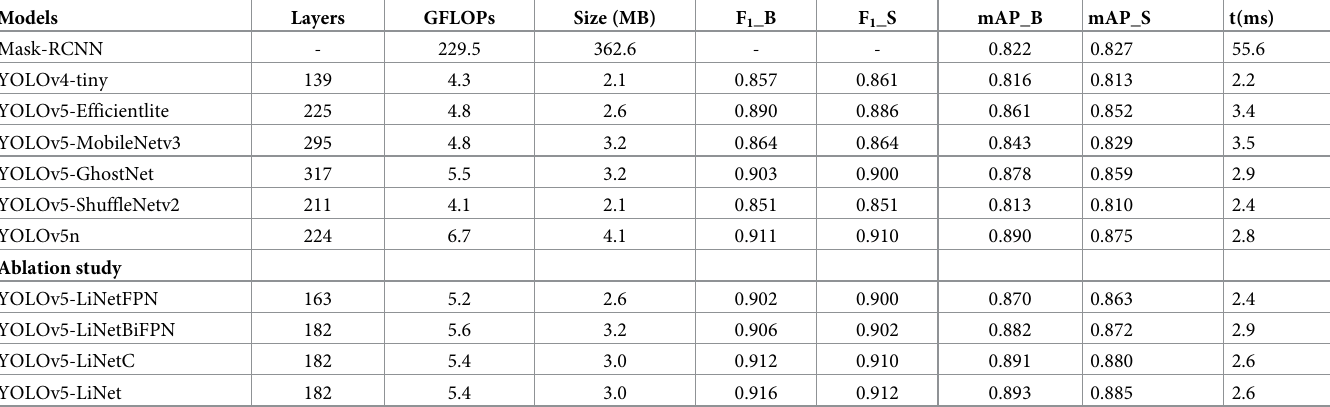
Table 2. Compared summary performance of the tested models.